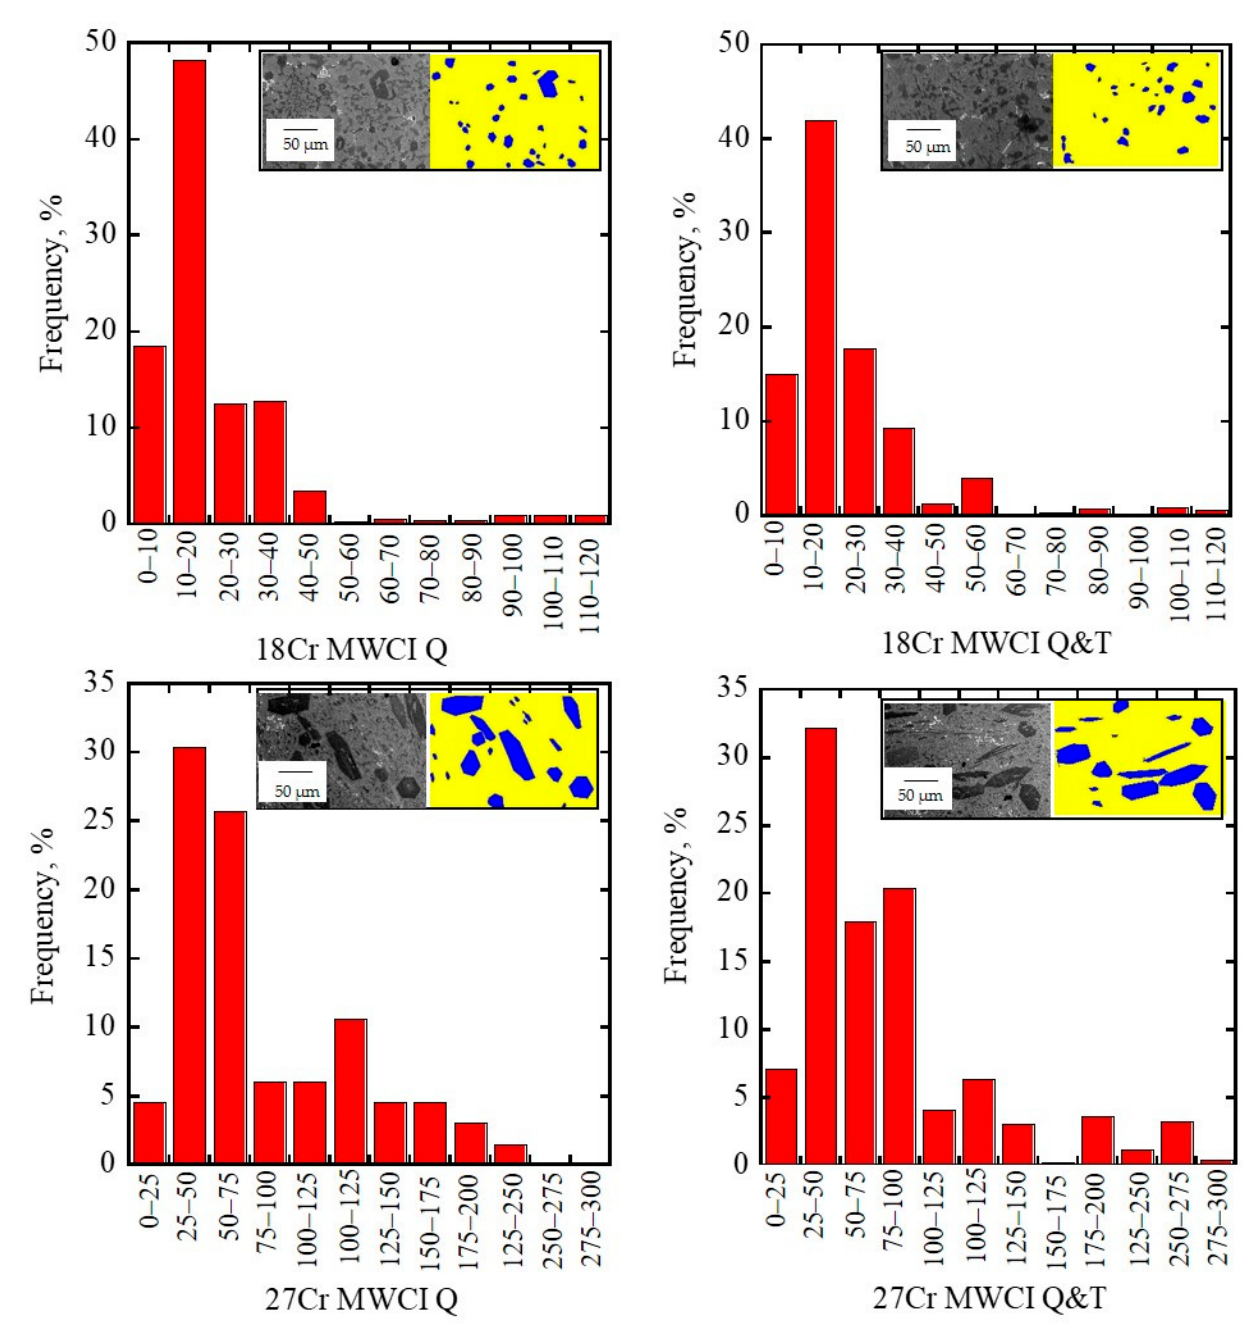
Figure 12. The M 7 C 3 carbide size distribution of high–Cr MWCI materials.